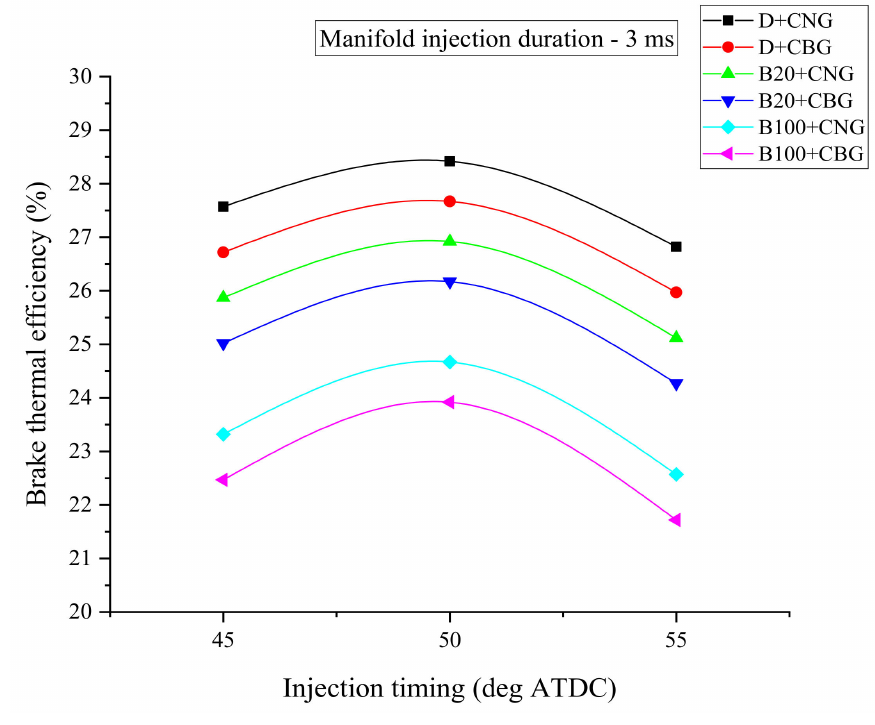
Figure 2. Variation of BTE with IT.